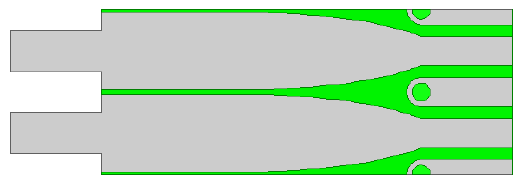
Figure 4: The complete, innovative, quadruple FLuS.